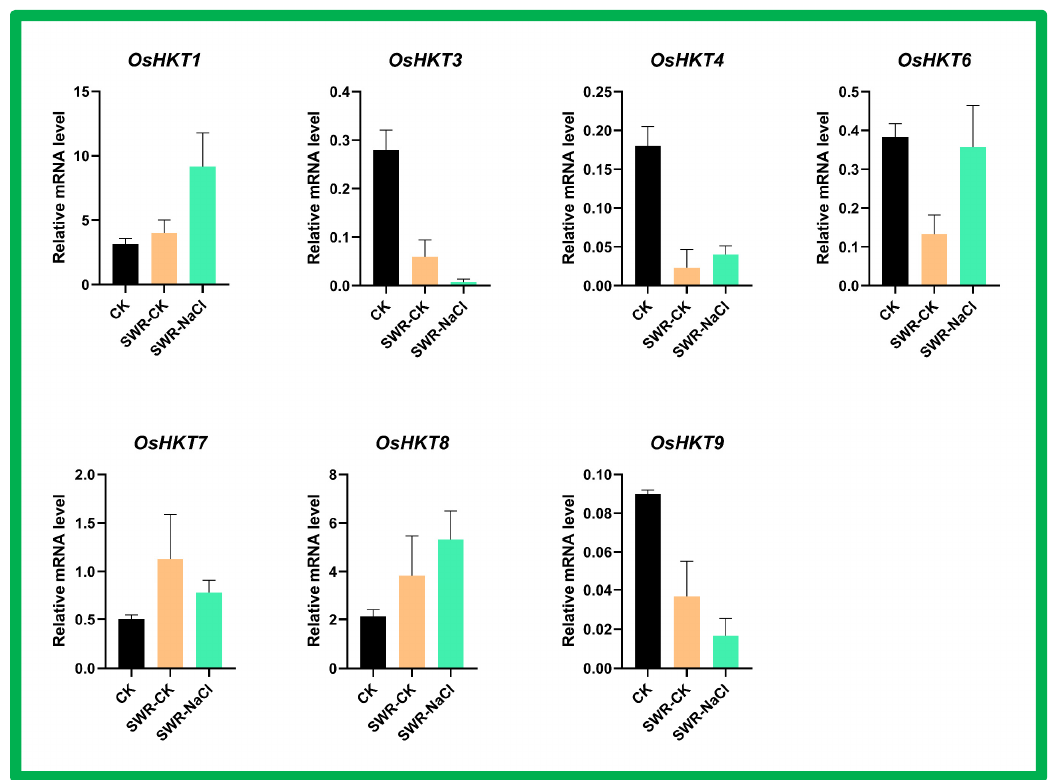
Figure 11. Expression analysis of the OsHKT gene family in the salinity resistant cultivar subjected to sea water stress. Control (CK) and seawater resistant (SWR). Different treatments are represented with different colors. ANOVA was used to test significance at p < 0.05 probability level. Error bars represent standard deviation.